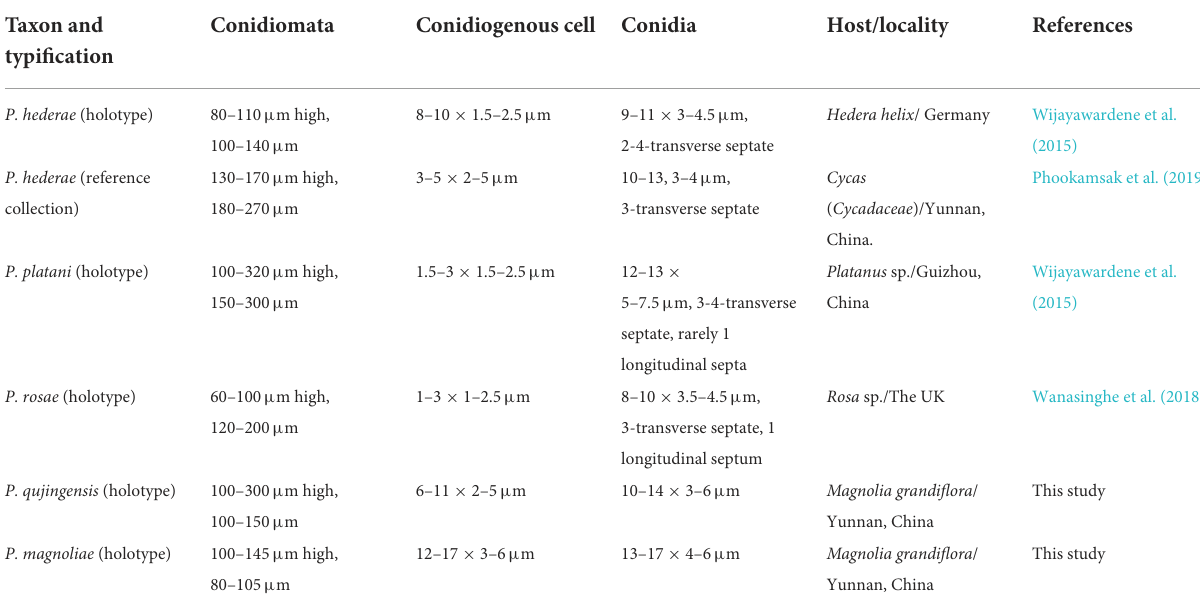
TABLE 4 Morphological comparison of Phragmocamarosporium